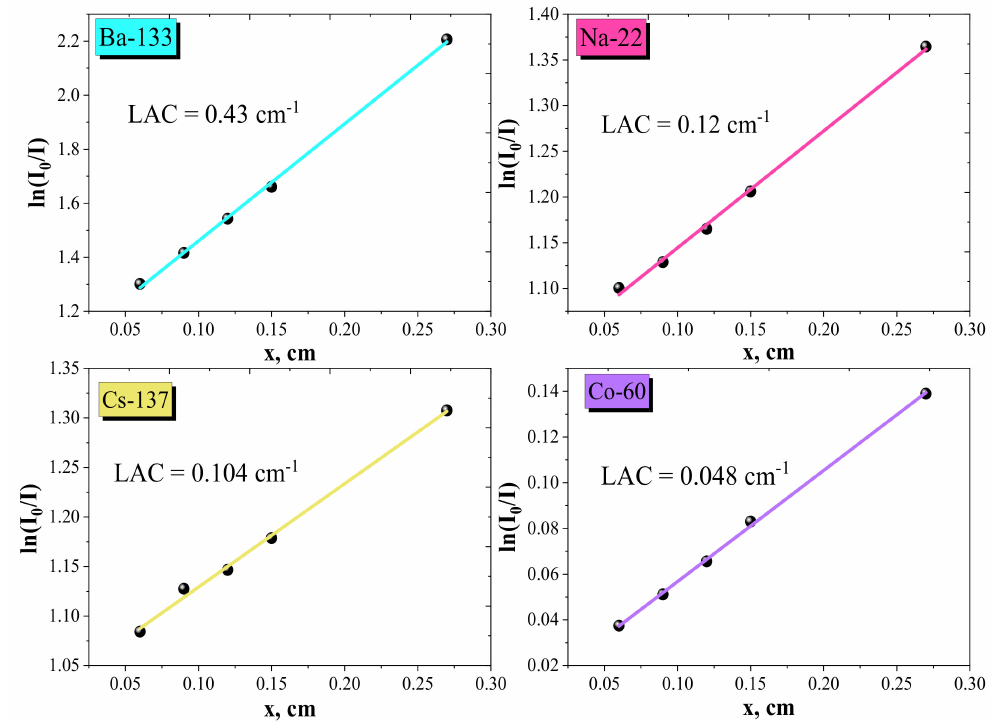
Figure 9. The variation of ln( I 0 / I ) with the thickness ( x , cm) of the W–Cu composites at different incident gamma photon